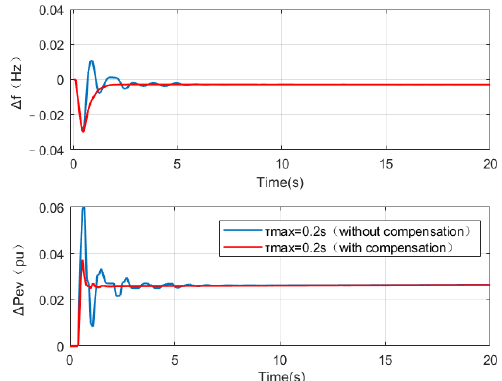
13 of 16 Figure 8. τ = 0.2 s system dynamic response with or without predictive compensation. Figure 9. τ = 0.9 s system dynamic response with or without predictive compensation.